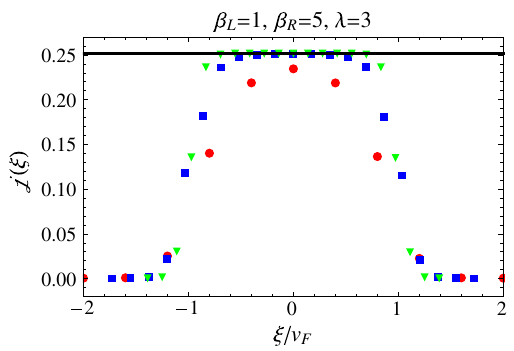
FIG. 5. Energy current in the Lieb-Liniger model for low temperatures λ ¼ 3 and chemical potentials μ ¼ 3 (circles), μ ¼ 6 (squares), and μ ¼ 10 (triangles). The CFT value π 1 − 1 (bold horizontal line) is reached for high values of 12 ð 25 Þ μ . By plotting the currents against ξ =v of the various curves, which becomes better as μ increases. The regions where plateaus emerge are roughly ξ =v ≈ 2 . 5 , 2.9, v F